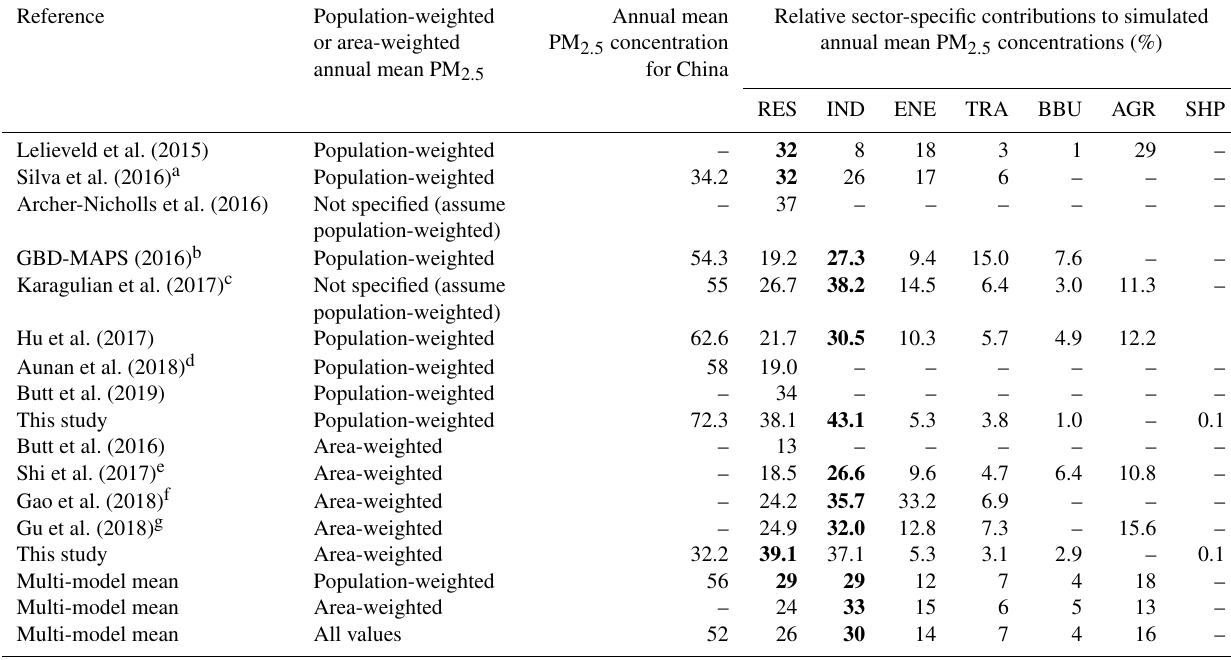
Table 4. Comparison of relative sector-specific contributions to simulated annual mean PM 2 . 5 concentrations over China from this study and previous studies. Emission sectors are residential energy use (RES), industrial non-power (IND), power generation (ENE), land transport (TRA), biomass burning (BBU), agriculture (AGR), and shipping (SHP). The largest relative contribution for each study is in bold. The average over all studies (multi-model mean) is shown for population-weighted, area-weighted, and all annual mean PM 2 . 5 concentrations and relative